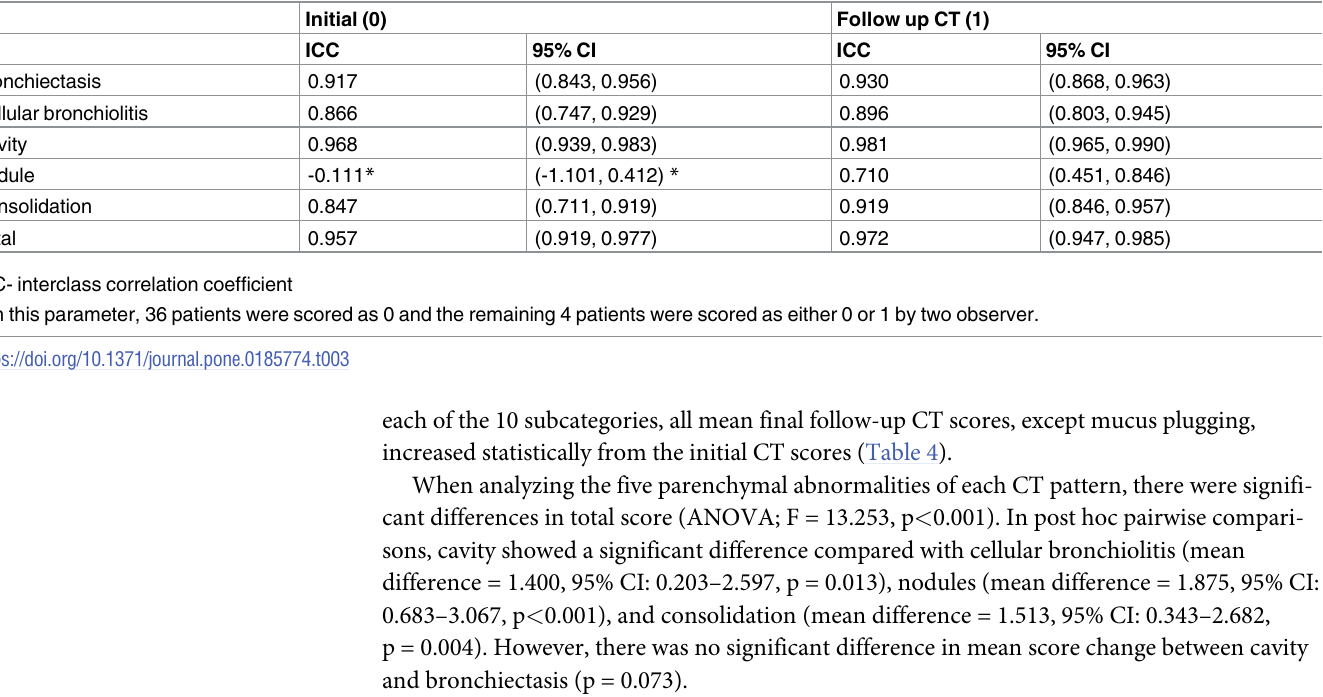
Table 3. Interobserver reliability for each radiologic findings of MAC lung disease assessdby interclass correlation coefficient.